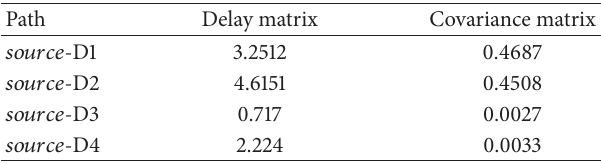
Table 3: Projection results with delay matrix and covariance